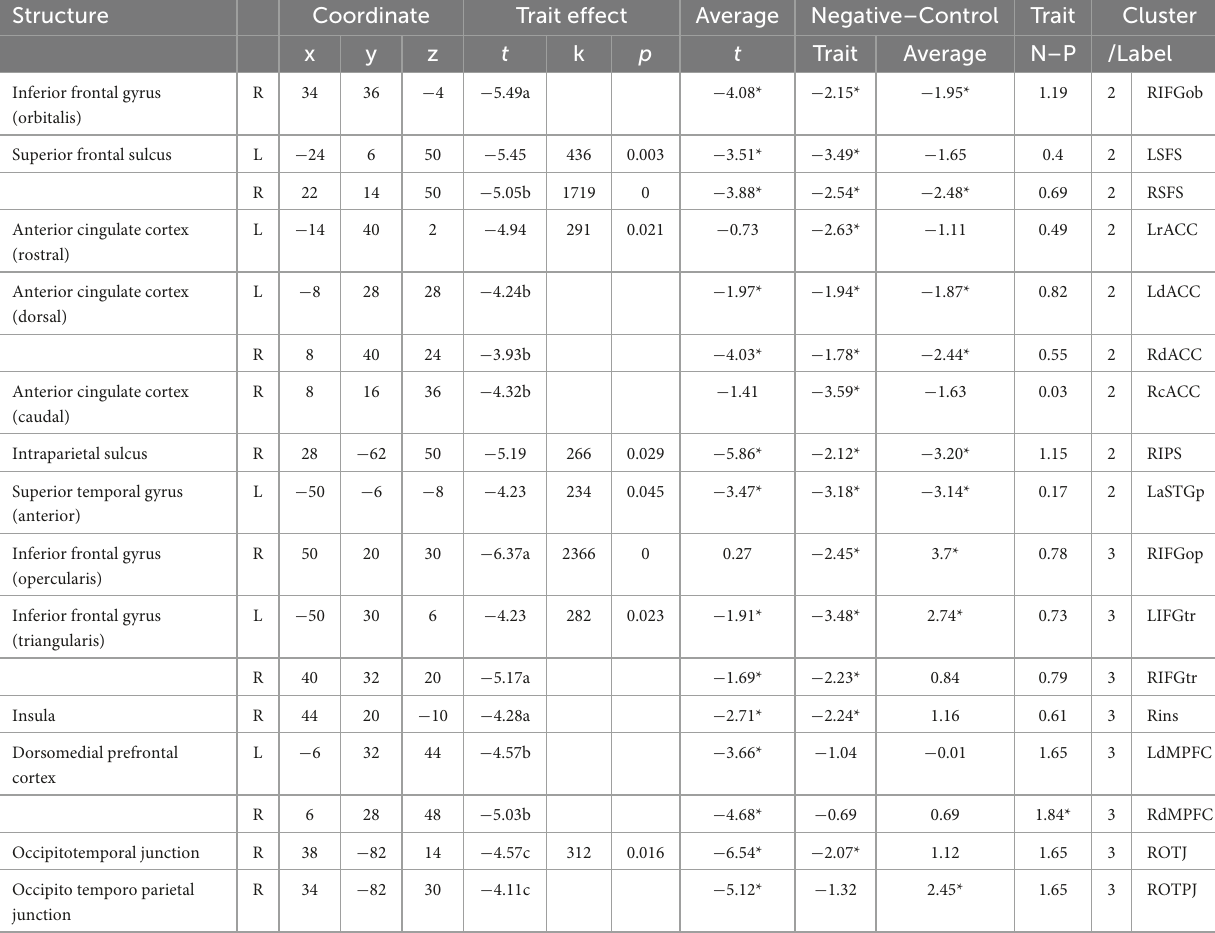
TABLE 2 Neural correlates of the automatic adaptive emotion regulation trait for positive emotional response. Structure Coordinate Trait effect Average